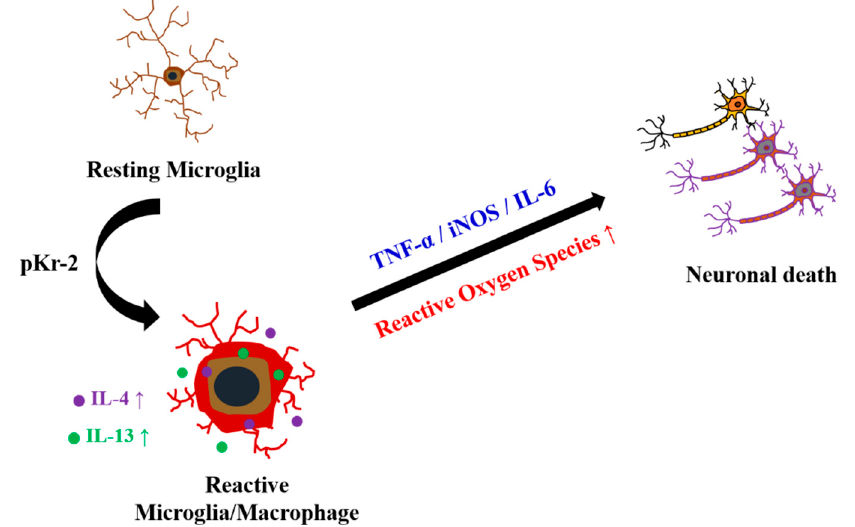
Figure 6. Interleukin-4 (IL-4) and IL-13 induced oxidative stress contributes to death of cortical neurons in pKr-2-treated cerebral cortex in vivo. pKr-2, Prothrombin kringle-2; IL-4, Interleukin-4; IL-13, Interleukin-13; TNF- α , Tumor necrosis factor- α ; iNOS, Inducible nitric oxide synthase; IL-6, Interleukin-6.